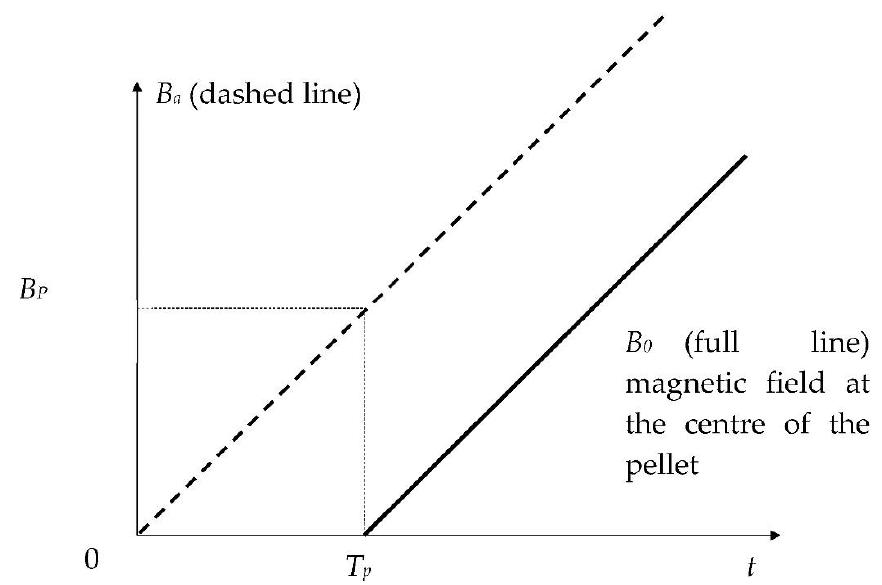
Figure 8. Applied magnetic field Ba ( t ) and magnetic induction at the center of the cylindrical HTS bulk Bo ( t ) .